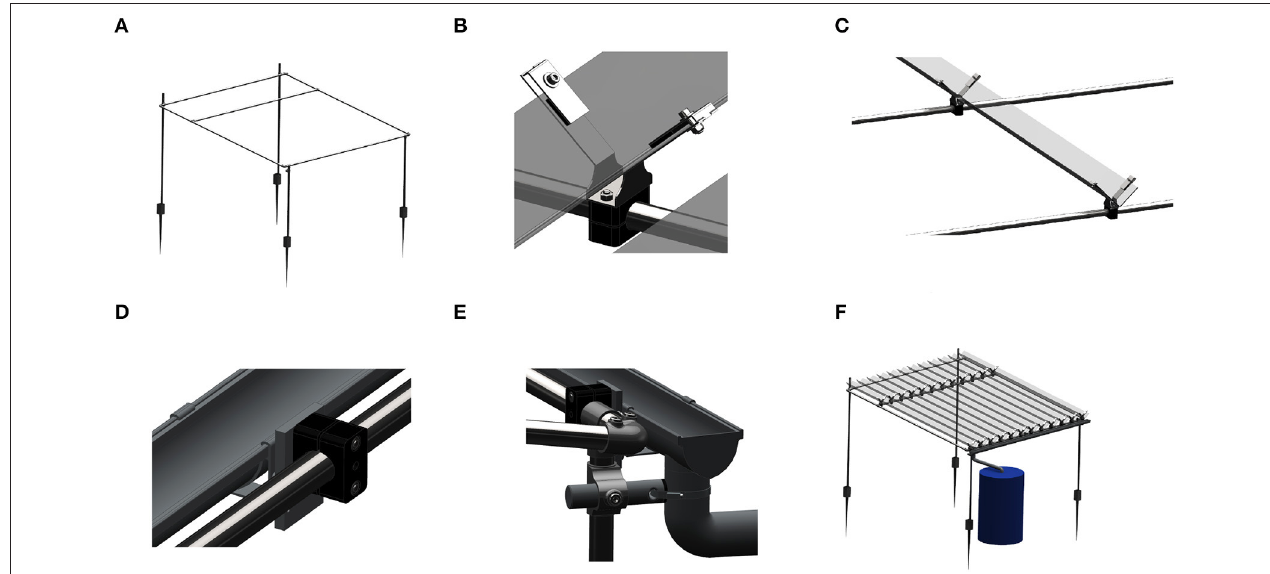
FIGURE 1 | (A) A metal frame (2.5 × 2.5m) serves as the basic rainout-shelter construction, the shelter is anchored in the soil using drive-in sleeves; (B) acrylic glass bands are fixed to the steel frame by specially designed holders; (C) the metal frame supports V-shaped clear acrylic glass bands in which rainfall is collected; (D) rain gutter holder consist of pipe clamp, adapter plate, and gutter bracket (view from the rear); (E) a T-pipe connector with adaptor piece holds the drain pipe in place; (F) the final rainout-shelter with partial rainfall interception and precipitation